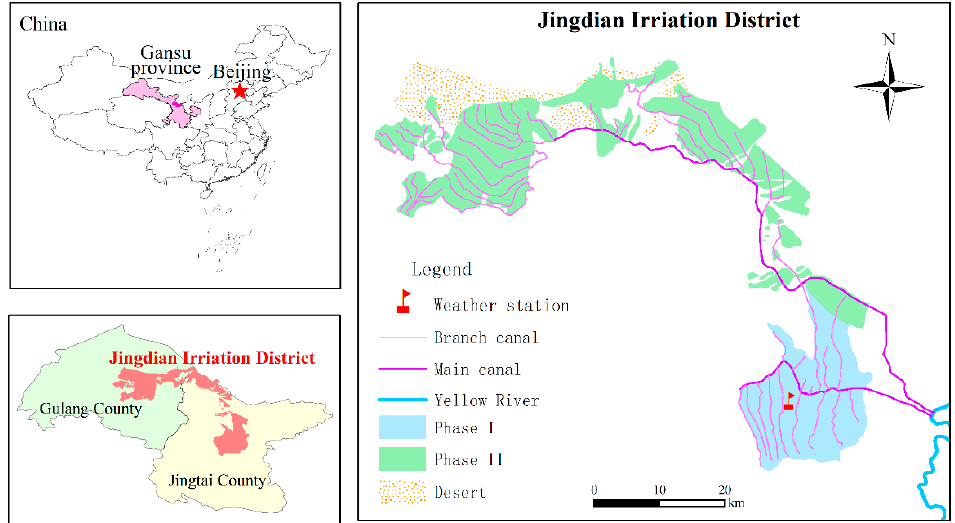
Figure 2. Location map of the study area.